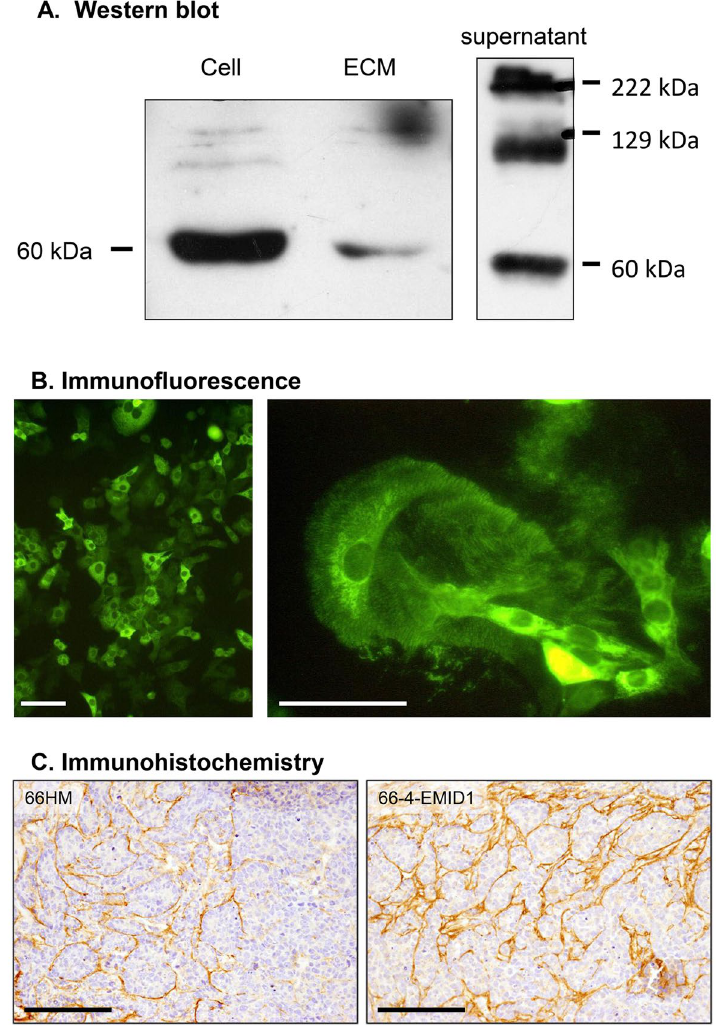
Figure 3. Expression and subcellular localization of EMID1 protein. ( A ) Western blots in non-reducing conditions of cell fractions of 66–4 cells transfected with the Emid1 expression vector. ( B ) Immunofluorescent image of in vitro localization of EMID1 protein overexpressed in 66–4 cells. EMID1 protein is expressed in the cytoplasm (left) and deposited on the dish surface with brush-like structures, which are seen following cell detachment with Triton-X treatment (right). Scale bar, 50 μm. ( C ) Representative immunohistochemical image of EMID1 protein expression in vivo tumor tissue of EMID1-overexpressing 66–4 cells and 66HM cells orthotopically inoculated into the mammary fat pad of syngeneic mice. EMID1 is linearly localized around the tumor nests of both 66HM cells (left) and 66–4 cells transfected with Emid1 expression vector (right). Scale bar, 100